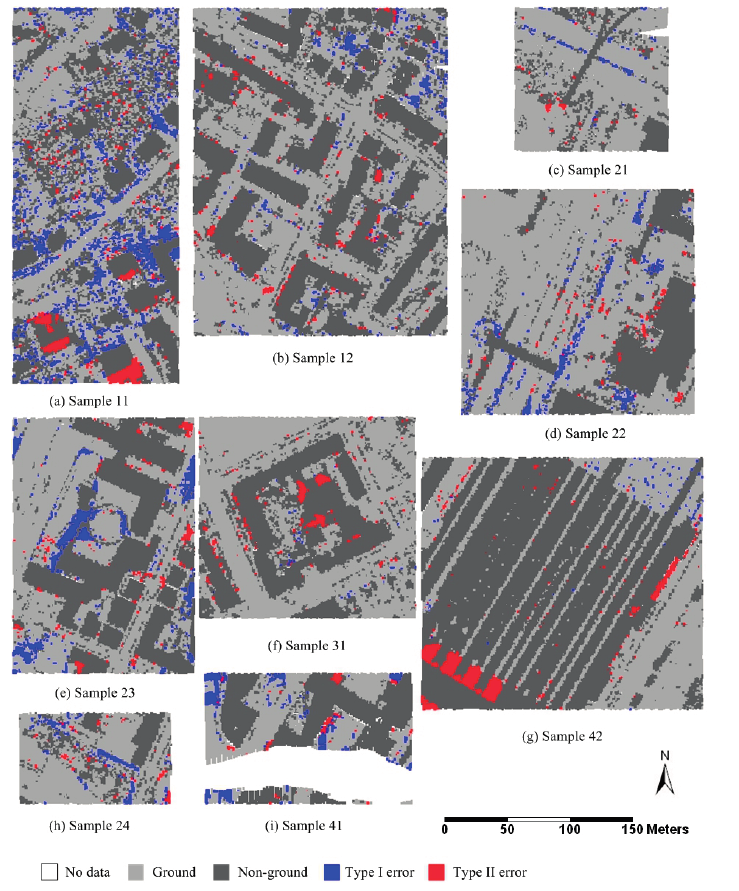
Figure 10. Spatial distribution of errors generated by filtering urban sample datasets.